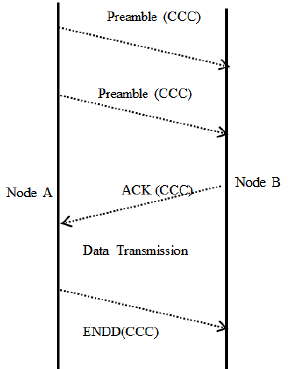
Figure 7 . Operation of the CR-WSN MAC protocol. CCC, common control channel; ACK, acknowledgement; ENDD, end of data.